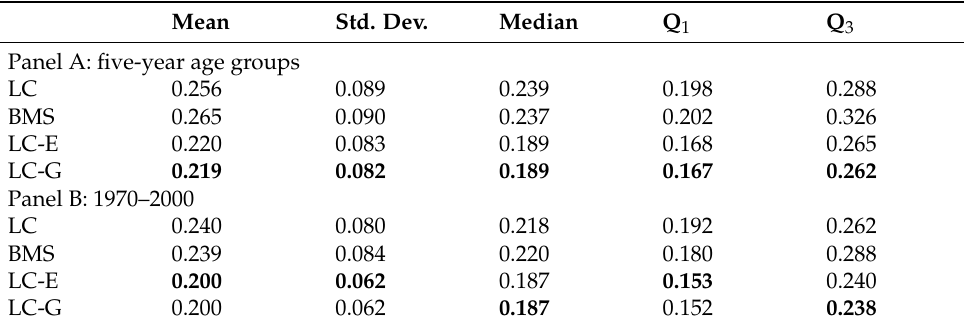
Table 3. Summary of robustness checks: age and temporal variations. Mean Std.